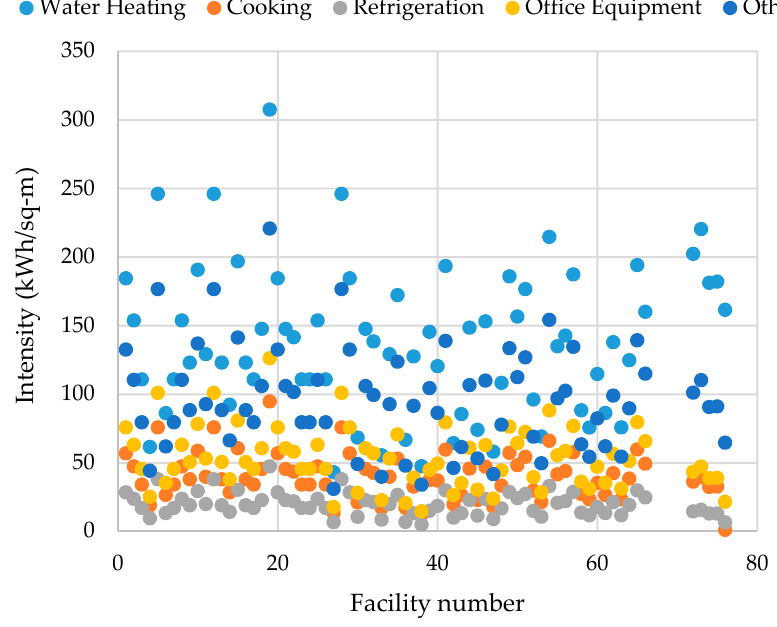
Figure 7. Healthcare facilities’ annual process energy intensity.